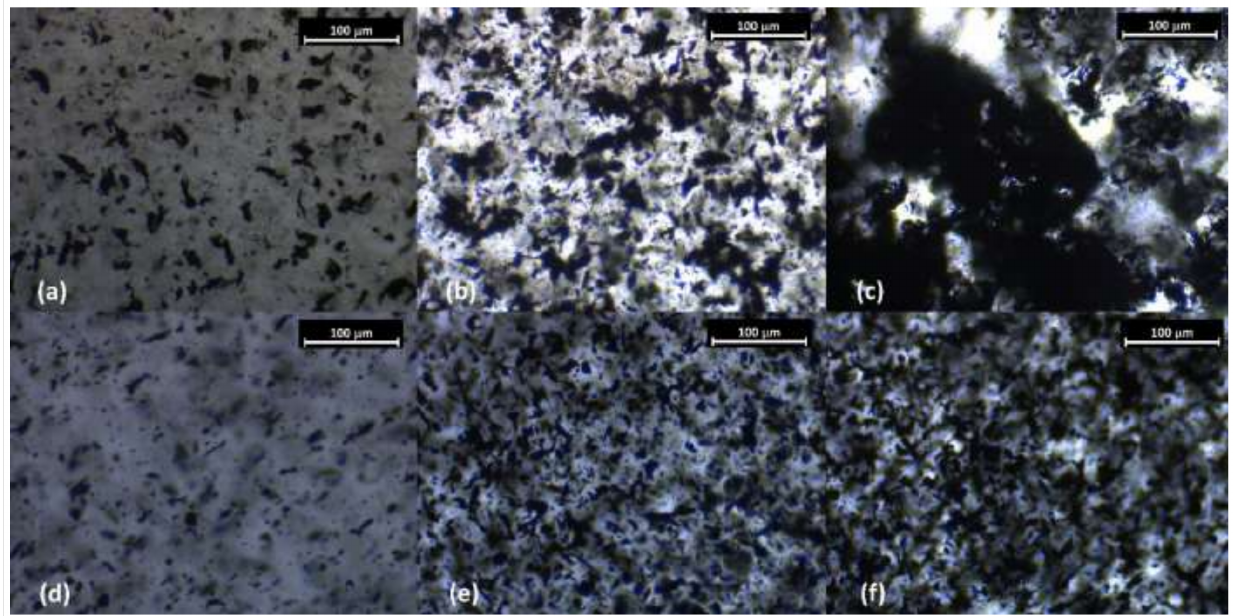
Figure 2. Optical microscopy images of the film samples of the different polymer matrices with different GNPs concen- trations. ( a ) PHA + 0.15 wt.% GNPs, ( b ) PHA + 0.75 wt.% GNPs, ( c ) PHA + 1.50 wt.% GNPs, ( d ) PLA + 0.15 wt.% GNPs, ( e ) PLA + 0.75 wt.% GNPs and ( f ) PLA + 1.50 wt.%